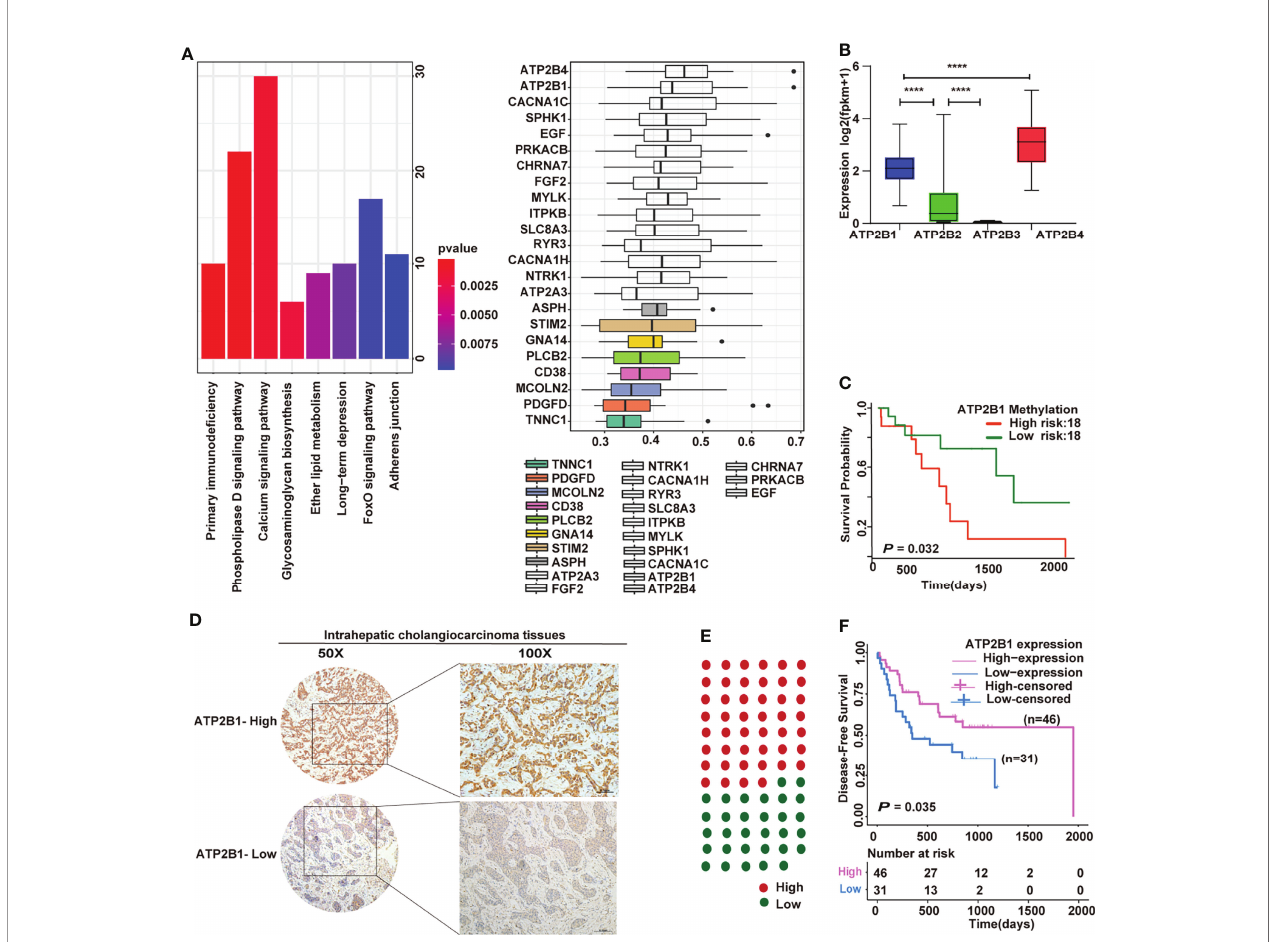
FIGURE 3 | Prognostic signi fi cance of ATP2B1 in ICC. (A) Pathway enrichment analyses and semantic similarities of gene classes by GOSemSim; (B) Expression of four genes in cholangiocarcinoma from TCGA; (C) Kaplan – Meier curves of the association of ATP2B1 gene methylation with overall survival; (D) Representative IHC staining of ATP2B1 in ICC tissues; (E) Proportions of ICC case with different ATP2B1 expression levels; (F) Association of ATP2B1 expression with better disease- free survival in